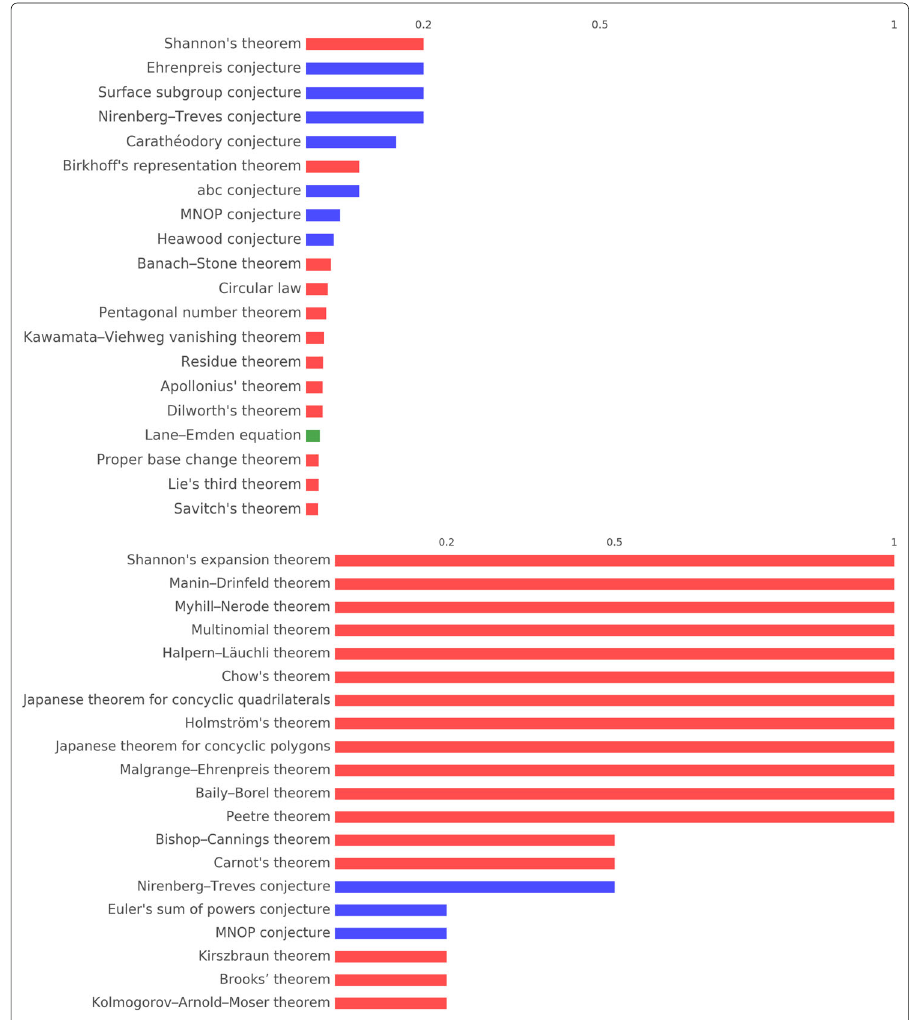
Fig. 11 Concept importance in S 3 stars 20 most important concepts appearing in the core (top) and the periphery (bottom) of S 3 stars. The bars reports the number of appearances in cores or peripheries divided by the number of appearance in triangles and tetrahedra